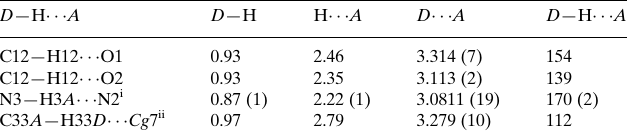
Hydrogen-bond geometry (A˚ , (cid:2) ). Cg 7 is the centroid of the C27–C32